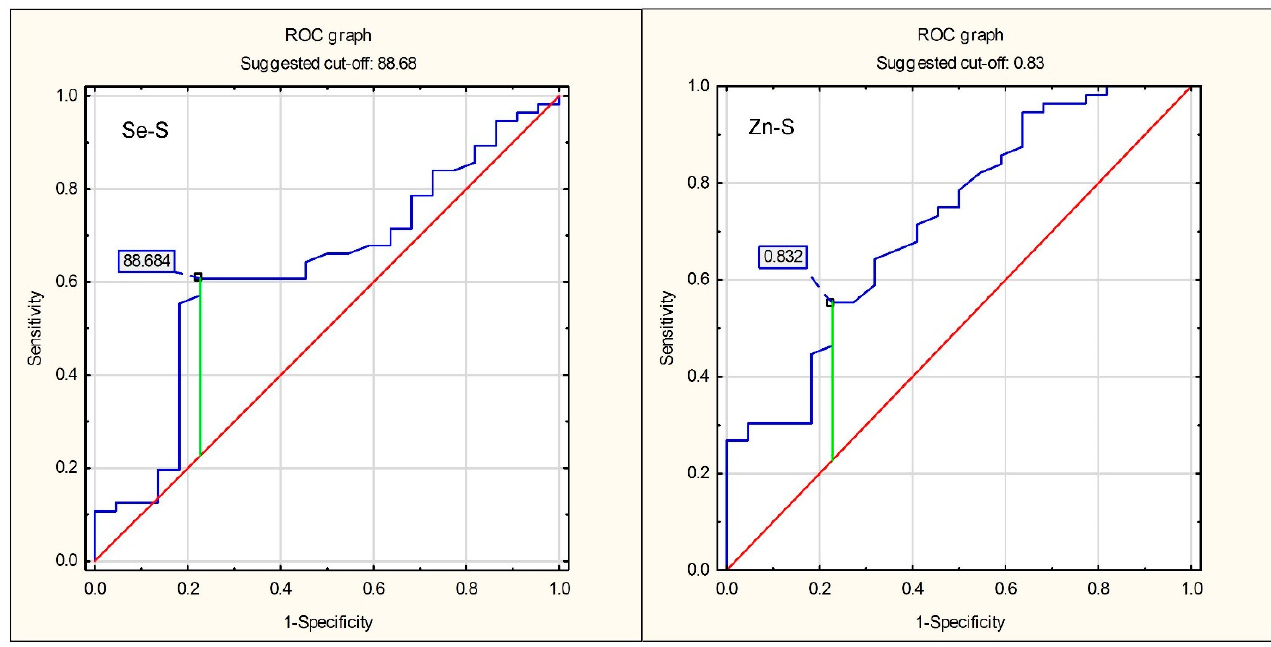
Figure 2. ROC curves for prediction of left ventricular hypertrophy using serum selenium concentration and serum zinc concentration. The blue line is the ROC curve of the assessed variables, the red line is the diagonal reference line. The sensitivity, specificity and accuracy of the criterion Se-S < 88.86 µg/L as a LVH predictor were 77.3%, 58.9% and 64.1%, respectively; the analogous parameters of the accuracy analysis for the criterion Zn-S < 0.83 mg/L as an LVH predictor were 77.3%, 55.4% and 61.5%, respectively. The complete parameters of accuracy analysis for Se-S and Zn-S as the left ventricle hypertrophy predictors are shown in Table 6.